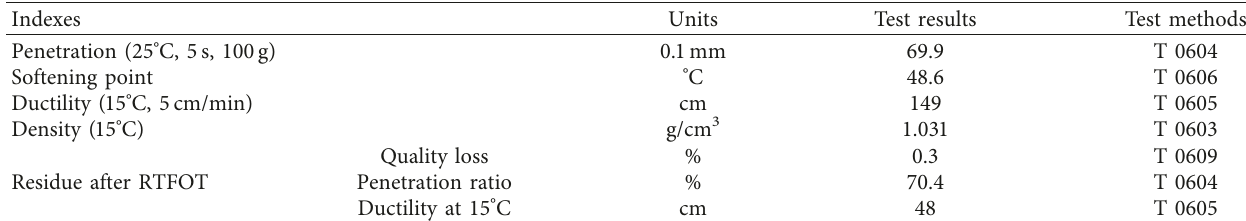
Table 7: The properties of AH-70 virgin